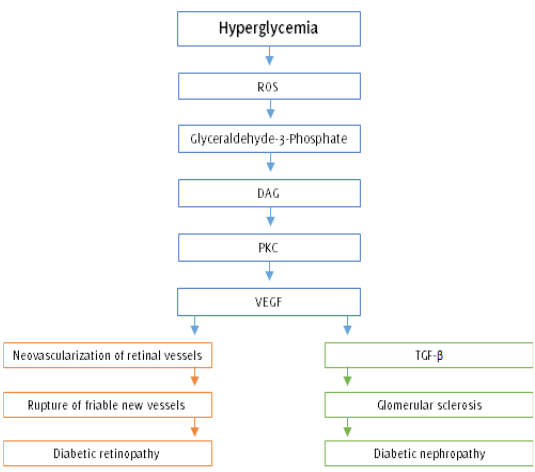
Figure 2. Hyperglycemia: The Role of Protein Kinase C Activation in Diabetes Complications.